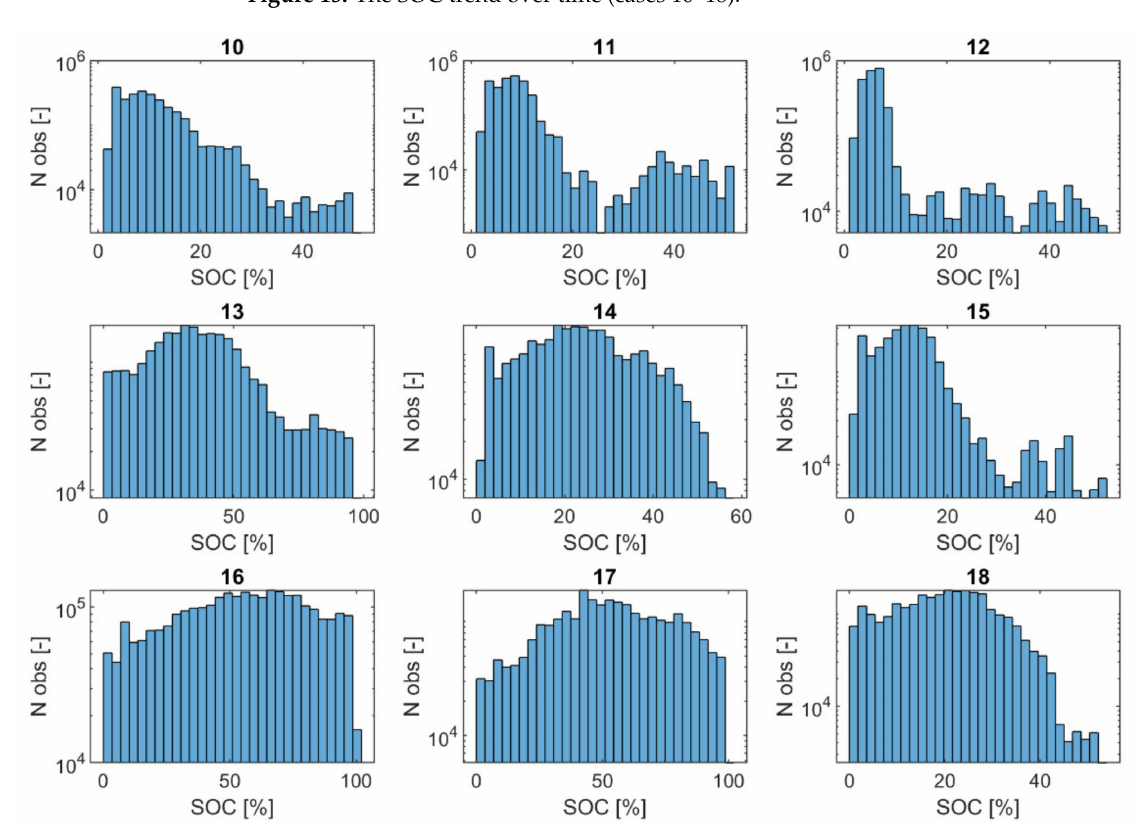
Figure 16. The SOC distribution (cases